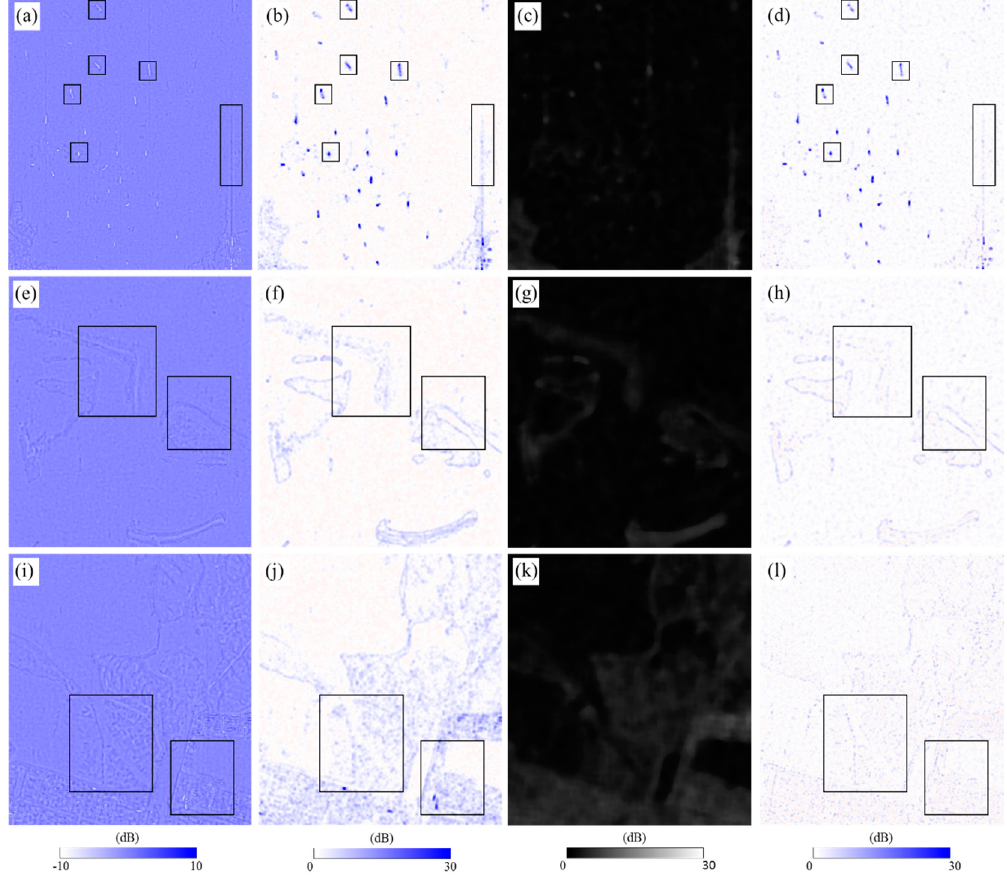
Figure 4. Procedure for the generation of a texture-differential image, which is another input layer used for ANN: ( a , e , i ) the difference between sigma-naught and NL-means-filtered images, ( b , f , j ) the texture images, ( c , g , k ) the median-filtered texture images and ( d , h , l ) the texture-differential images in the boxes A, C and D (see Figure 1).